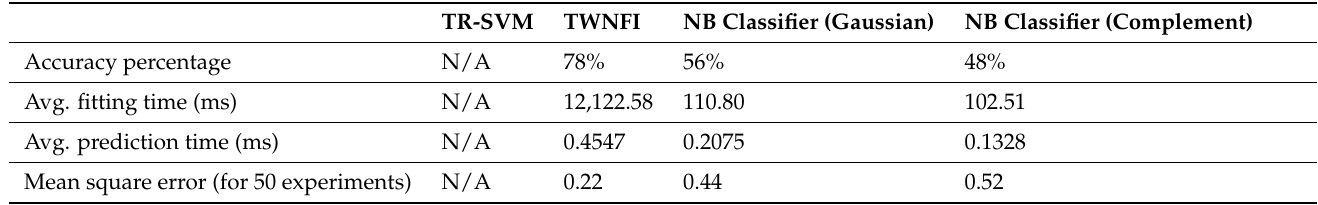
Table 6. Comparison of chosen machine learning algorithms for the whole